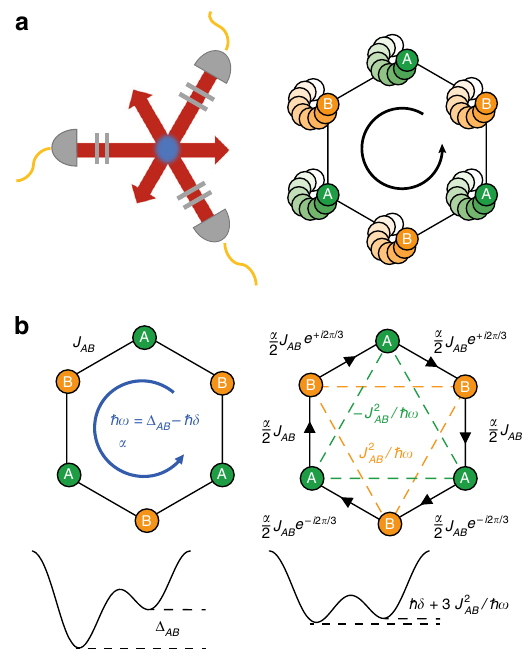
Fig. 1 Illustration of the linking number of dynamical vortices. The fi gure shows the Brillouin zone (hexagon) and trajectories of momentum-space phase vortices. One can de fi ne a linking number between the static vortices (straight green line) and the dynamical vortex contour (gray closed line). The linking number is zero in the left panel and one in the right panel, which can be directly mapped to the Chern number of the underlying Hamiltonian (illustrated by the sphere and torus). The initial Hamiltonian is assumed to be topologically trivial throughout the manuscript, which is ensured by starting with a static optical lattice, where time-reversal symmetry is not broken